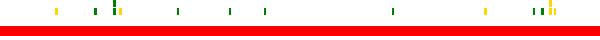
A graphic map of the distribution of the target-DNA sites recognized by 15 ZFNs obtained along the entire length of the HIV-1 genome. This figure offers a graphic map of distribution of target DNA sites recognized and cleaved by the 15 ZFNs along the full 9,182 bp lengths of the HIV-1 genome. For details, see additional file 3.